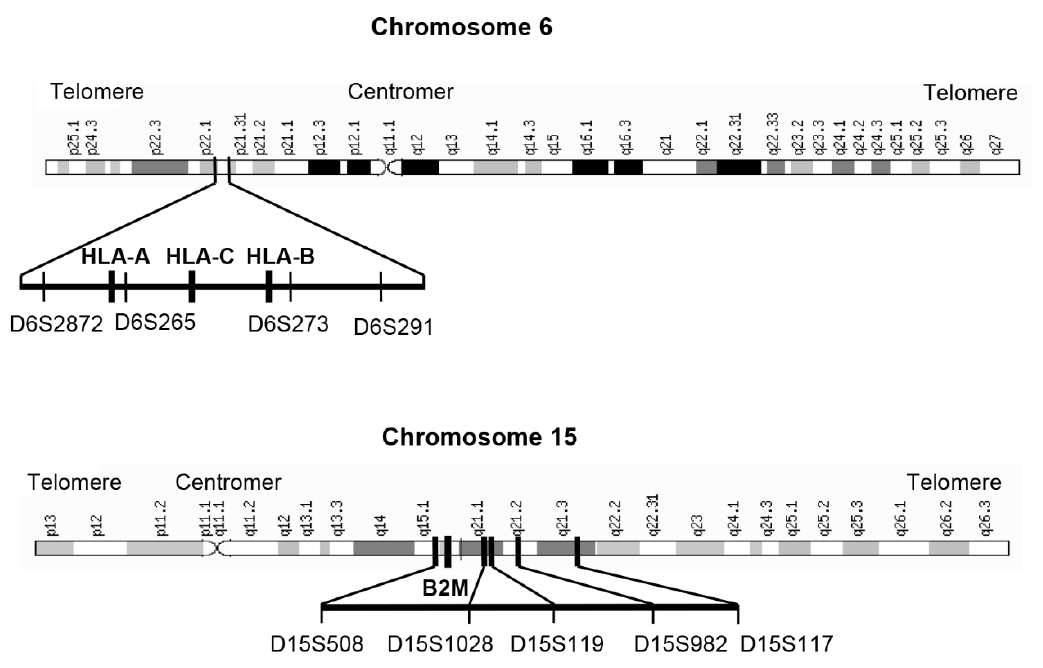
Figure 1. Chromosomal localization of the microsatellite markers. Localization of the microsatellite markers at chromosome 6p21 relative to the HLA-A, HLA-B, and HLA-C genes and of the microsatellite markers on chromosome 15q21 relative to the B2M gene region is shown.